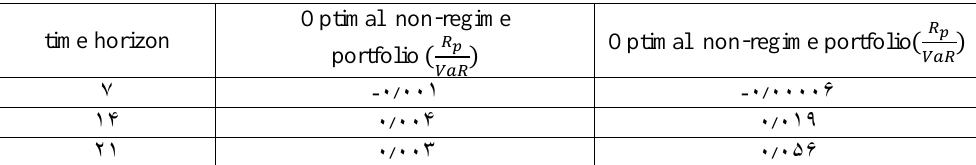
Table 17. Comparison between regime and non-regime optimal portfolios in the